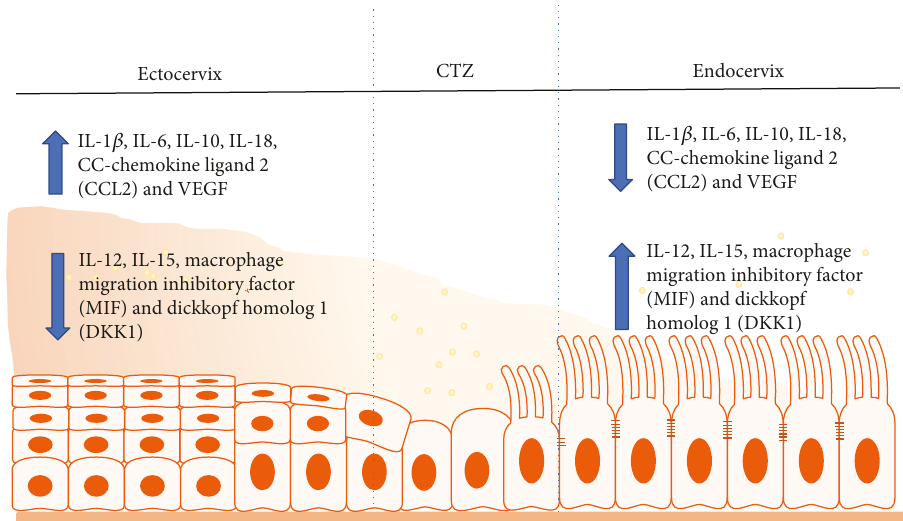
Figure 6: Cytokine pro fi le, distribution, and expression pattern in the ecto- and endocervix. Full names of abbreviations: interleukin (1 β , 6, 10, 12, 15, 18), vascular endothelial growth factor (VEGF).